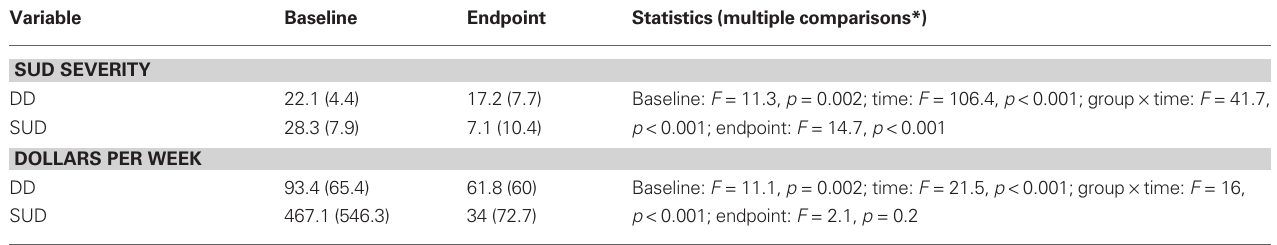
Table 2 | Substance use disorder outcomes.